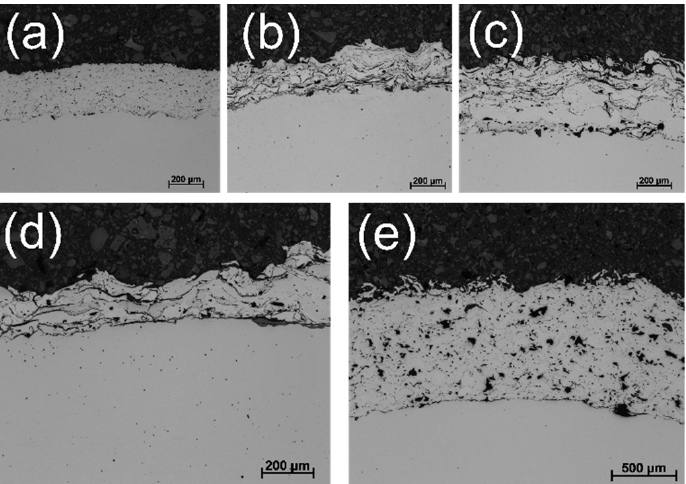
Figure 6. Optical light micrographs of the thermally sprayed coatings after 5000 h at 500 °C in model atmosphere: ( a ) HVOF Amperit 469, ( b ) TWAS 45CT, ( c ) TWAS Alloy 625, ( d ) TWAS pseudo-alloy, and ( e ) Plasma K50—16Mo3 steel base material.